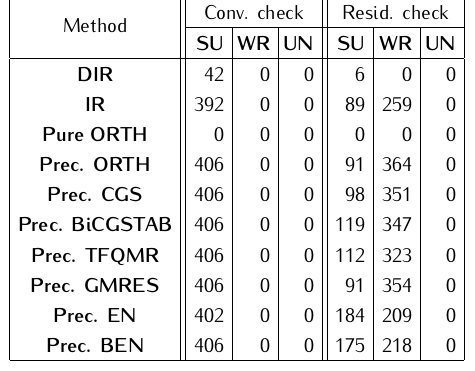
Table 15. Numerical results obtained when 42 matrices produced by the matrix generator CLASSF